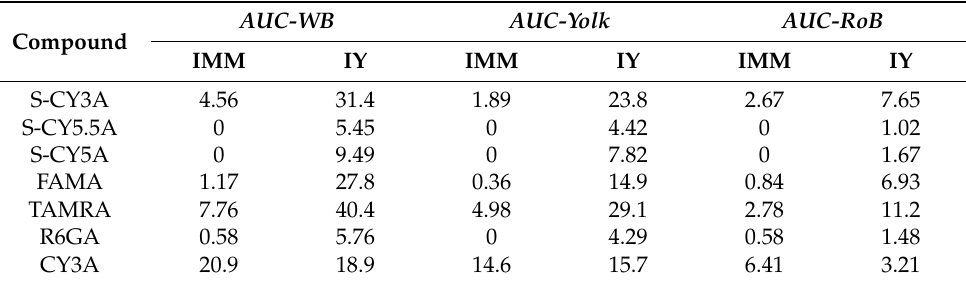
Table 1. AUC 0.25–72h values calculated following immersion (10 µ M) and intrayolk microinjection (2 mg/kg) from 0.25 to 72 h for the whole-body (WB), yolk and RoB parts. AUC 0.25–72h values expressed as RFU × 10 7 . AUC-WB AUC-Yolk AUC-RoB Compound IMM IY IMM